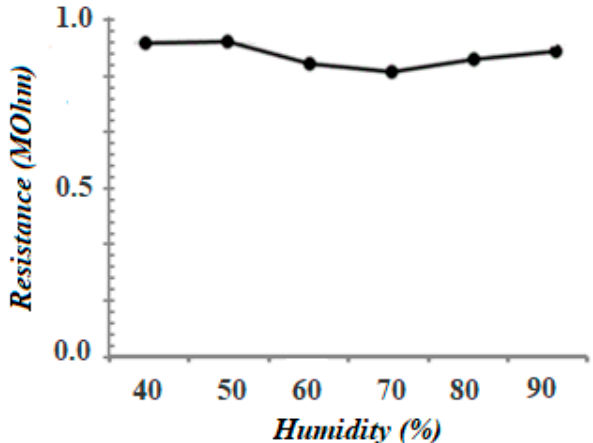
Figure 12. Dependence of sensor resistance on air humidity for the sample thermally treated at 500 °C (operating temperature = 25 °C).